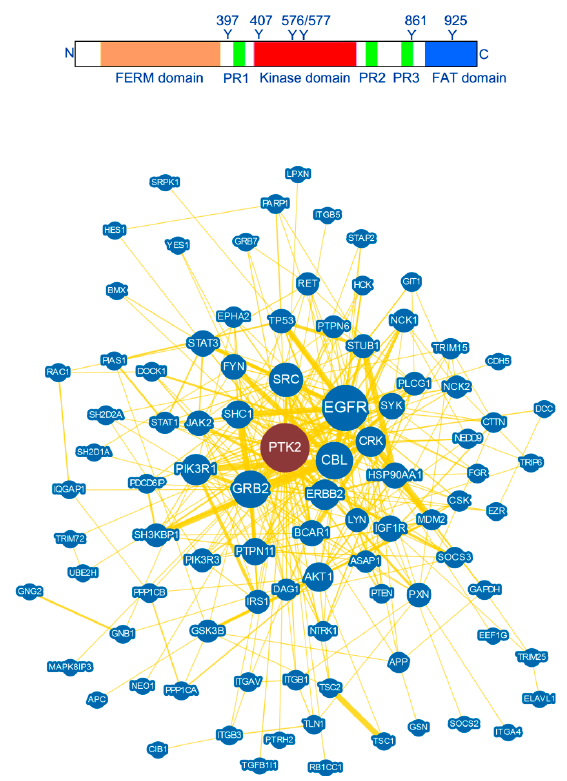
Figure 1. The main structure domains of FAK. Important sites of tyrosine phosphorylation are also indicated. Graphical network of FAK protein interactions identified by BioGRID based on a compilation of publications referring to protein and genetic interactions. Circles with layers closest to the centre are more highly connected.